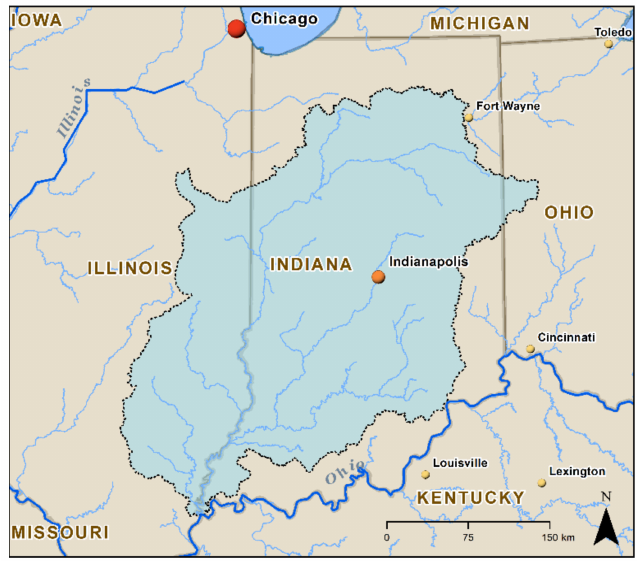
Figure 1. Wabash River